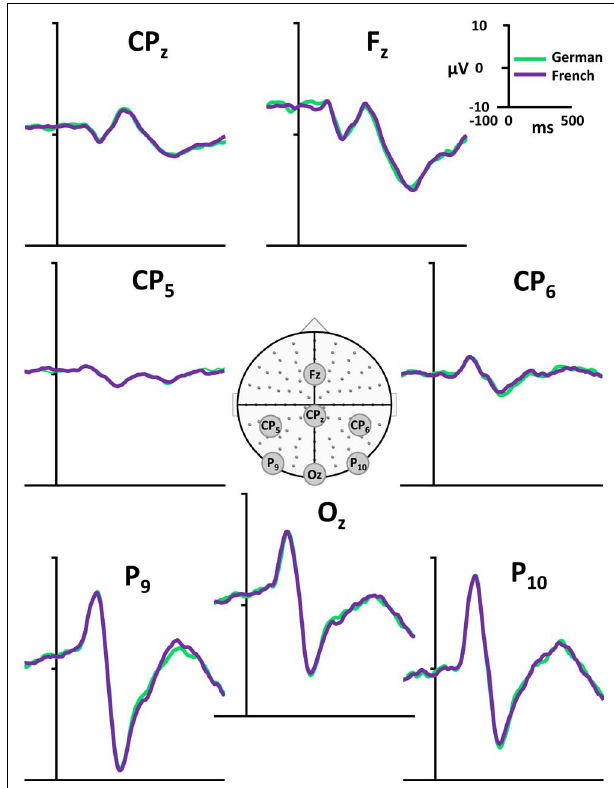
FIGURE 2 | Exemplar ERP waveforms. Exemplar group-averaged ERP waveforms (F z , CP z , Cp 5 , CP 6 , P 9 , P 10 , O z ) to PW reading in French (violet) and German (green) language context are plotted in microvolts as a function of time. In the middle of the figure, the array of the 128 electrodes with the electrode position of the displayed waveforms is